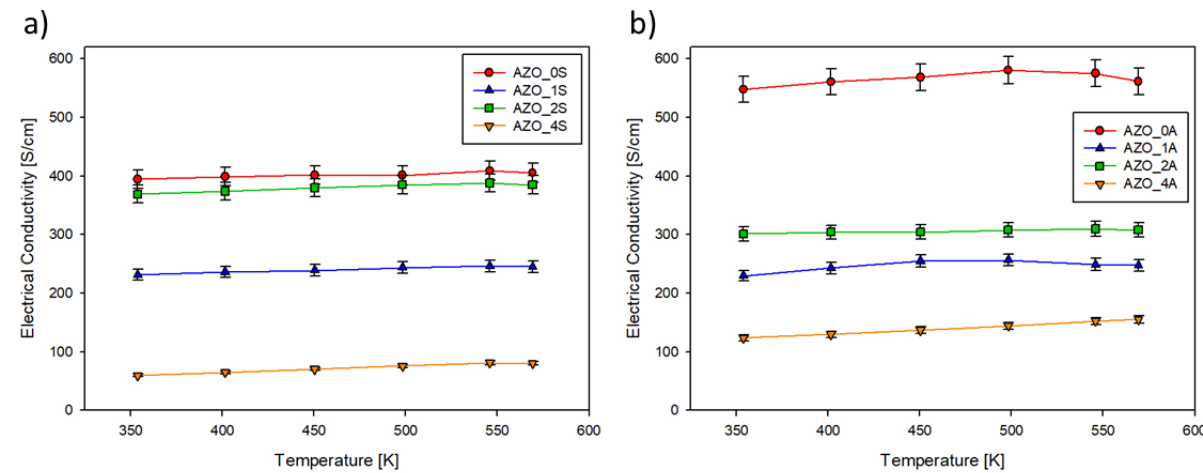
Figure 6. Electrical conductivity plotted vs. temperature of thin films deposited on ( a ) silica (series AZO_xS); ( b ) on Al 2 O 3 (series AZO_xA).